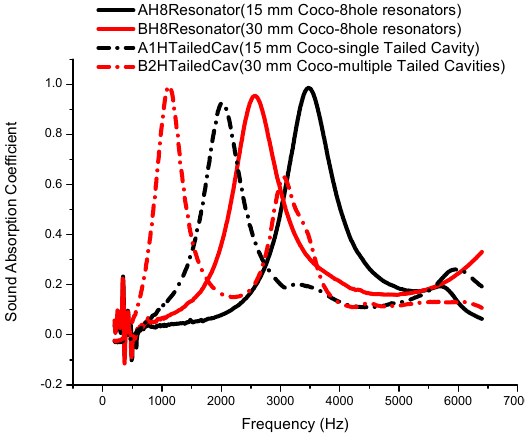
Figure 7. Absorption Comparison of coco-husk fiber reinforced polyester between previous research and present study.